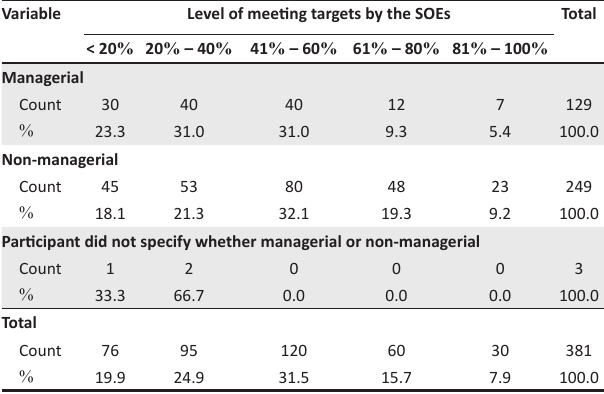
TABLE 2: Responses on the ability of state-owned enterprises to meet financial targets. Variable